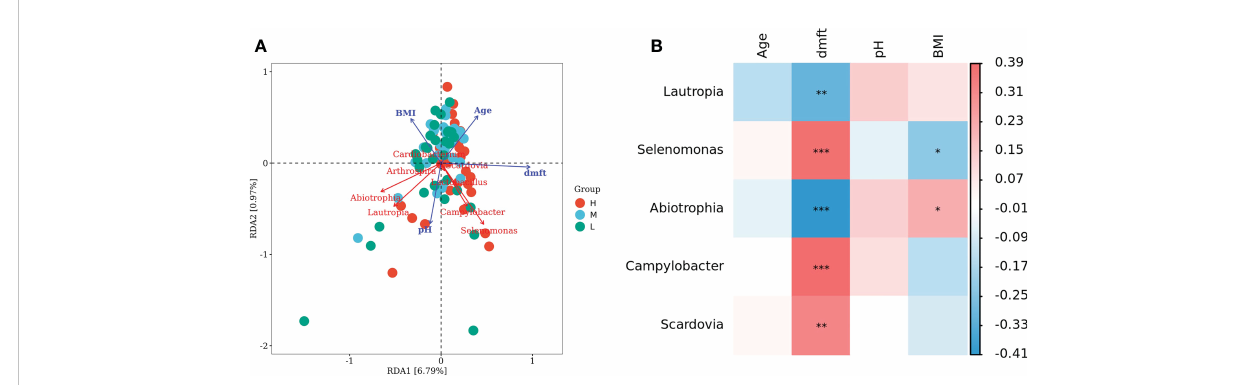
FIGURE 5 Connections between oral salivary microbiota and some indexes. (A) Redundancy analysis (RDA) of age, dmft, BMI, pH value and biomarkers between different CA groups. Each point represents a sample, different colored points belong to different groups. Blue arrows represent different indexes, red arrows represent bacterial genera, the angle between arrows represents the correlation between them. (B) Heatmap of association between age, dmft, BMI, pH value and biomarkers among different CA groups. Correction trait values are shown on the right, with default red representing a positive correlation, blue representing a negative correlation, and color depth indicating the strength of the correlation, * P < 0.05, ** P < 0.01, *** P <